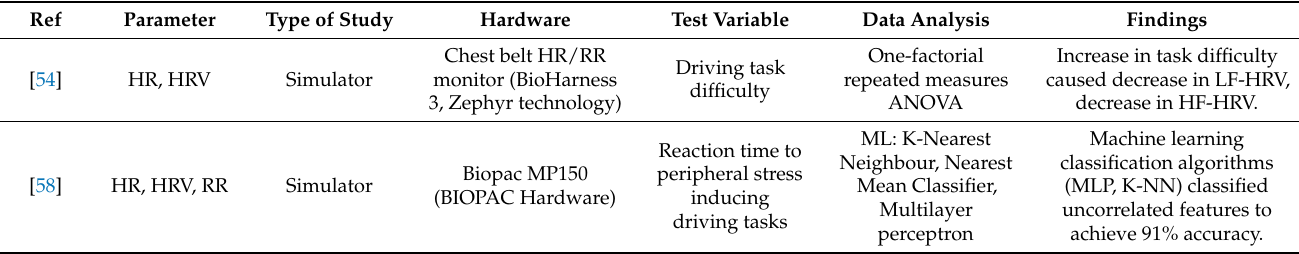
Table 3. Brief review of the selected 32